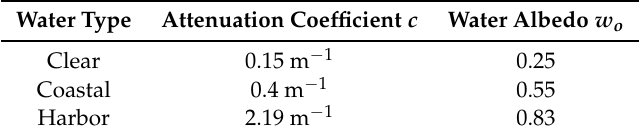
Table 2. Petzold’s measured water albedo and attenuation coefficients for the three water